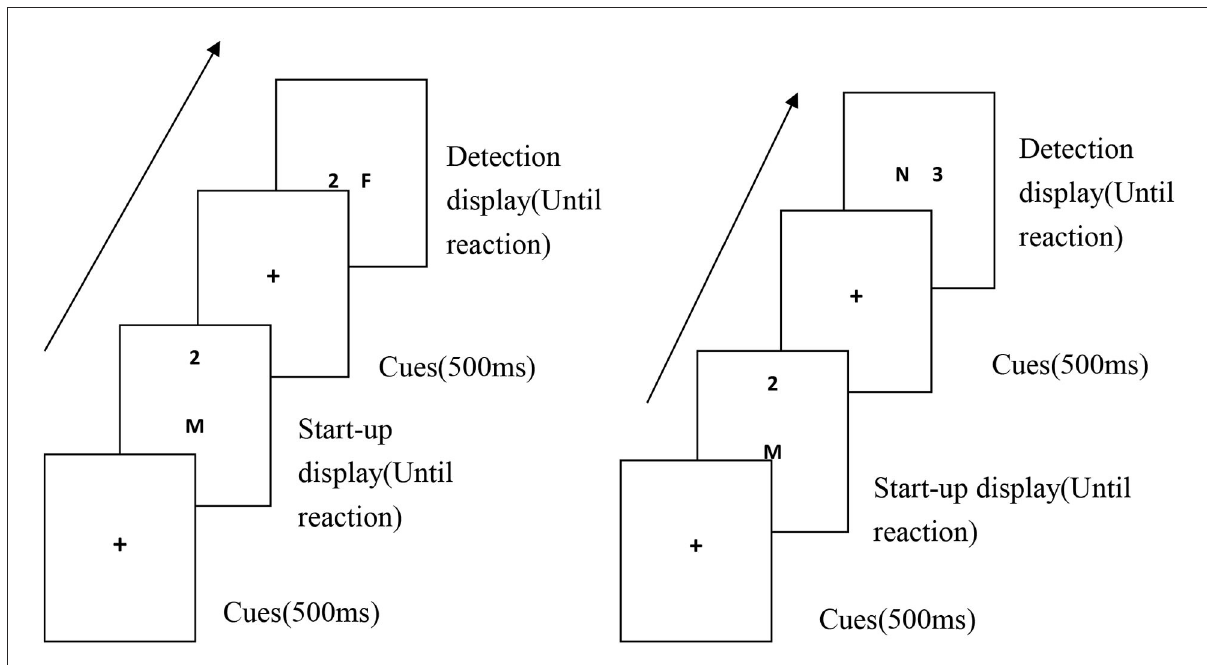
FIGURE1 Diagram of the experimental trial procedures under the characteristic negative priming condition.